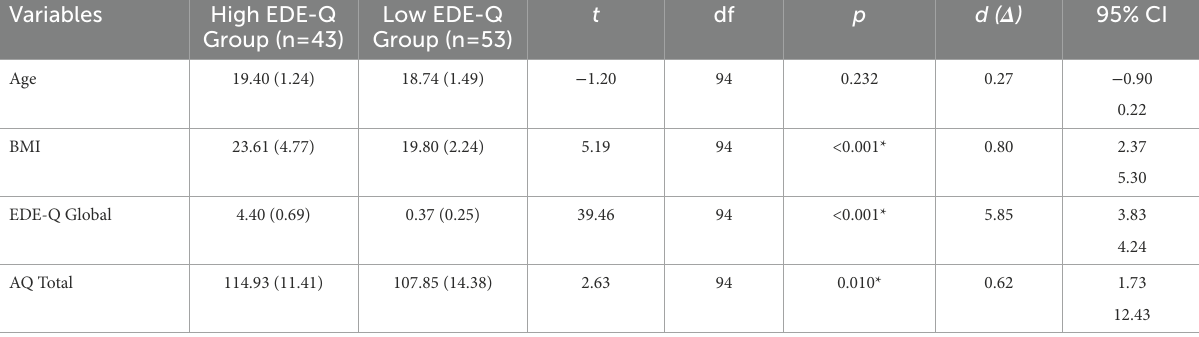
TABLE 2 Mean (SD) values and obtained t-test results for both high and low EDE-Q groups ( N = 96). Variables